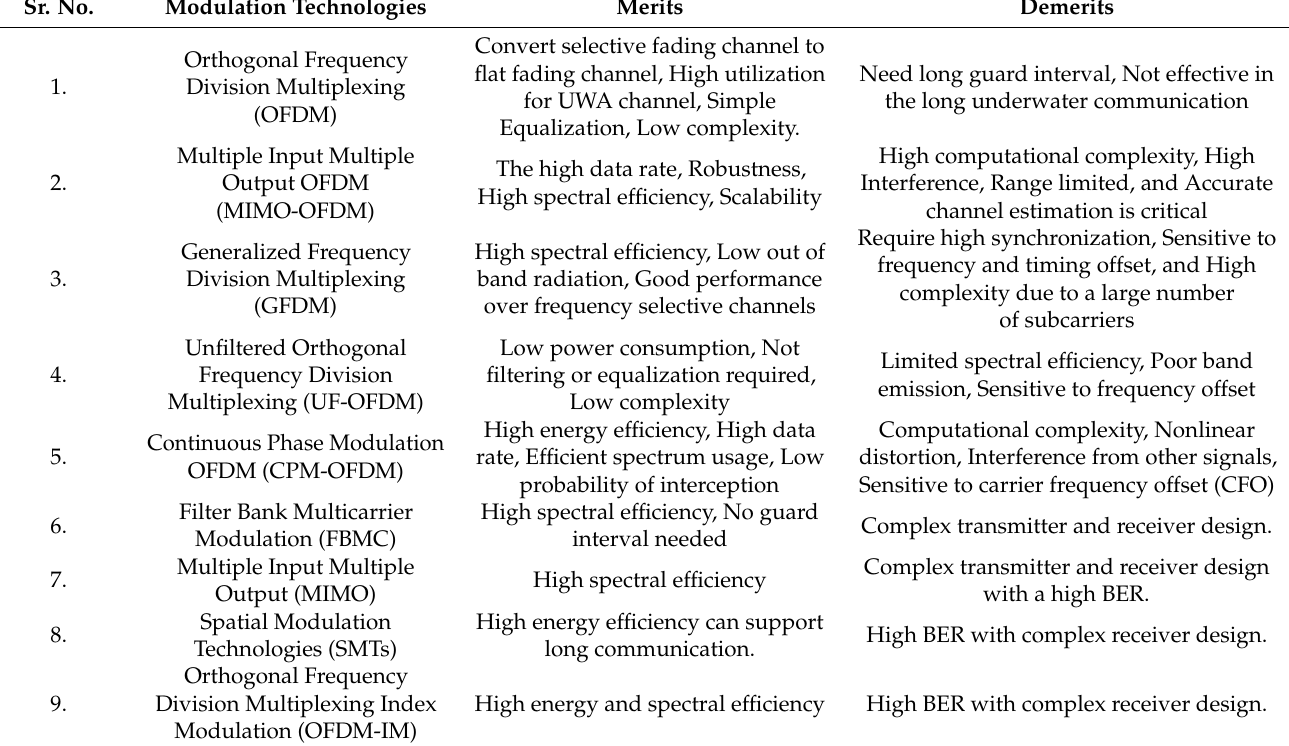
Table 3. Merits and demerits of UWA multicarrier modulation